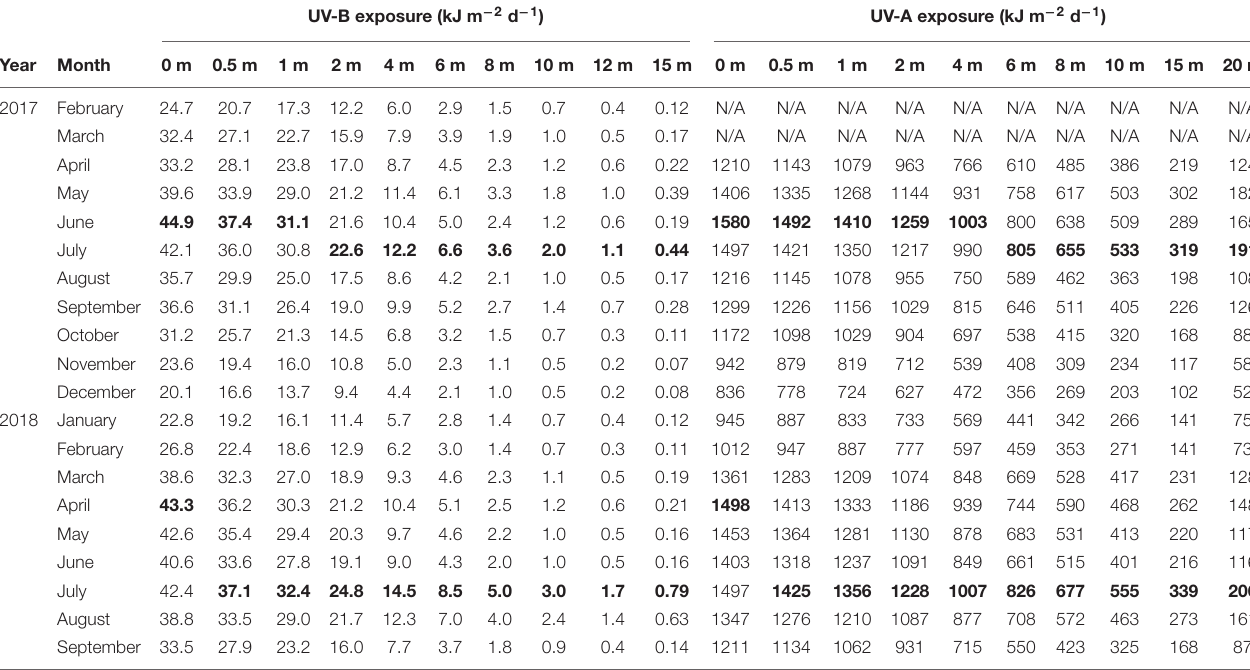
TABLE 4 | Mean daily exposure of UV-B (280–315 nm) and UV-A (315–400 nm) received in different depths of the water column at the Red Sea pelagic sampling station (22.309333 ◦ N, 38.997389 ◦